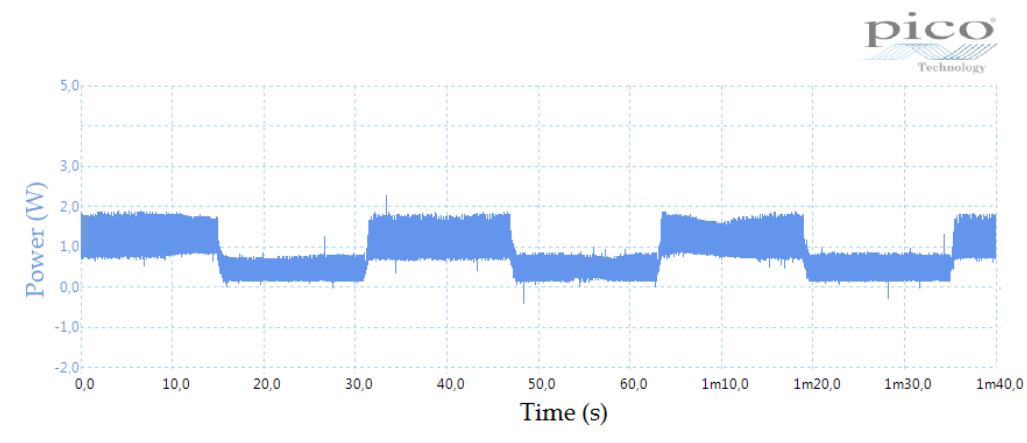
Figure 20. Power time evolution by employing the hysteresis MPPT